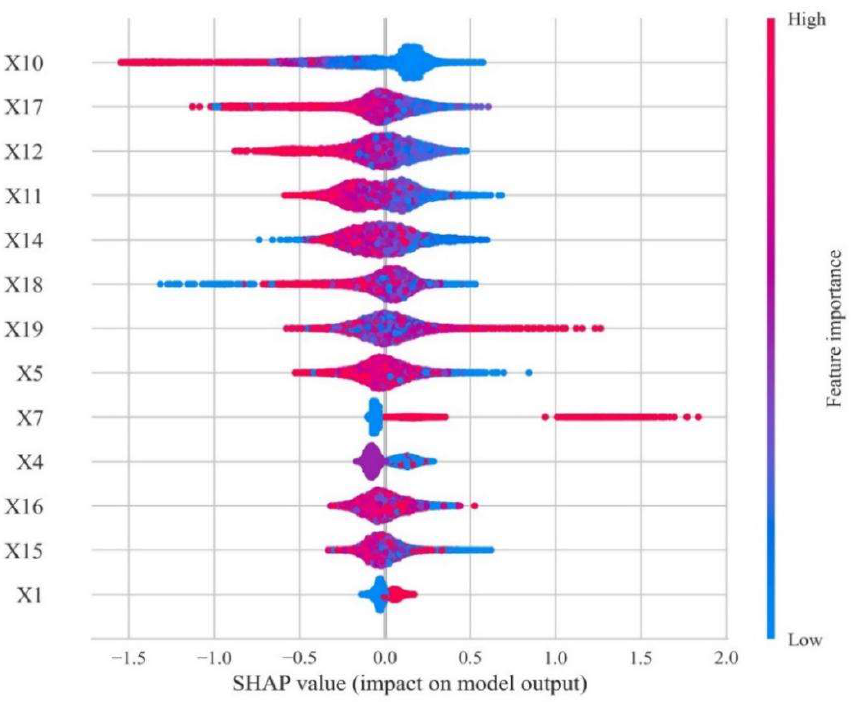
Figure 5. SHAP summary diagram of successful employment students.